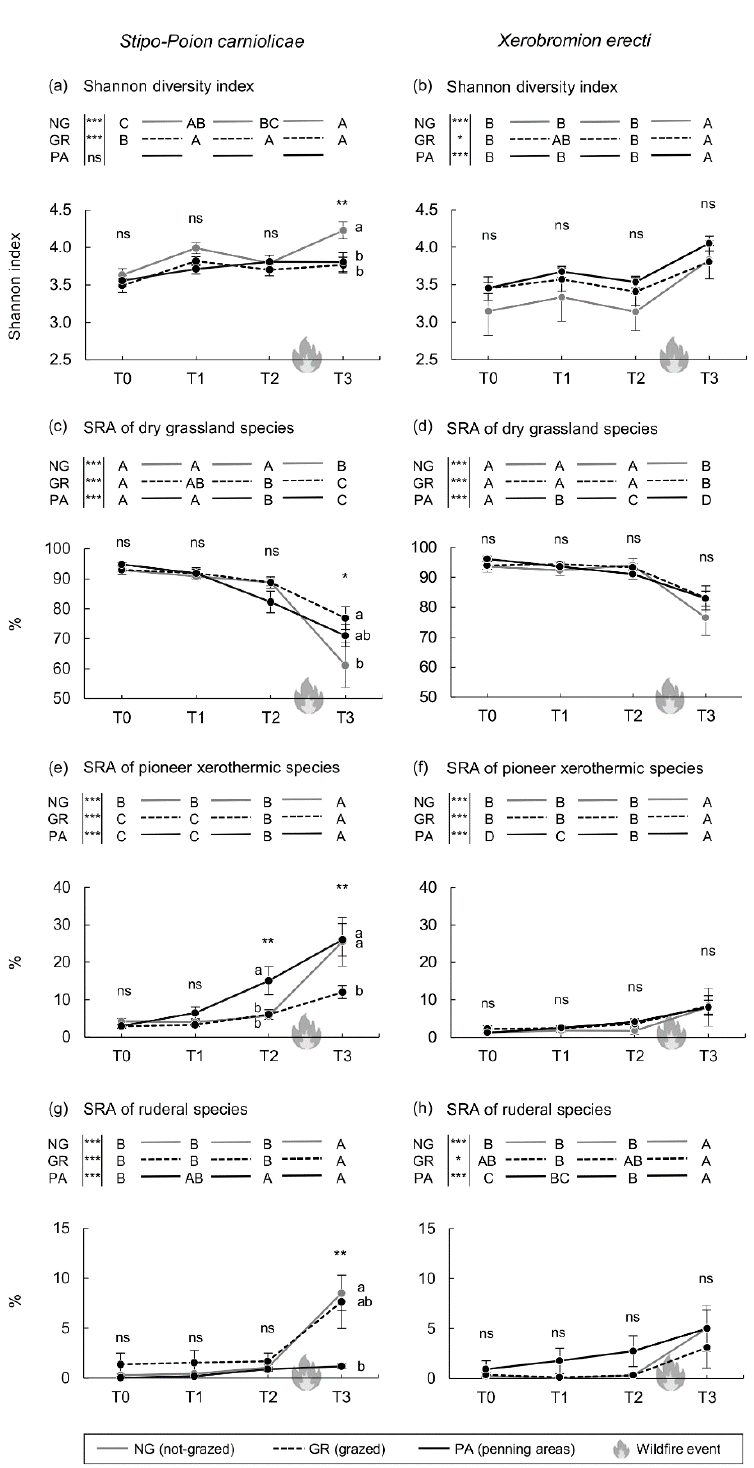
Figure 4. Results of the generalized linear mixed models performed on Shannon diversity index ( a , b ), SRA of dry grassland species ( c , d ), pioneer xerothermic species ( e , f ) and ruderal species ( g , h ) in Stipo-Poion carniolicae and Xerobromion erecti grassland types. Uppercase letters indicate significant differences among years within each treatment, while lowercase letters indicate significant differences among treatments within each year, according to Tukey’s post hoc tests. Years: T0, before grazing implementation; T1 and T2, after one and two years of grazing; T3, after the wildfire. Significance levels: ns, p ≥ 0.05; *, p < 0.05; **, p < 0.01; ***, p < 0.001.